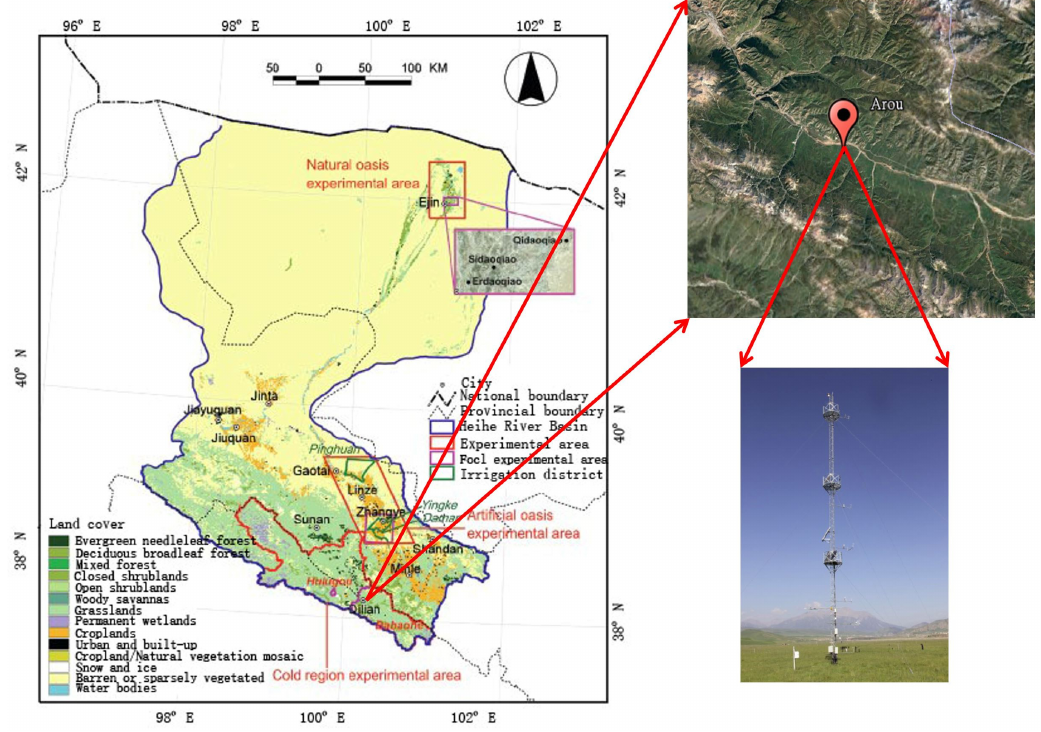
Figure 1. Landscape of the study site and observation equipment studied at A’rou station.